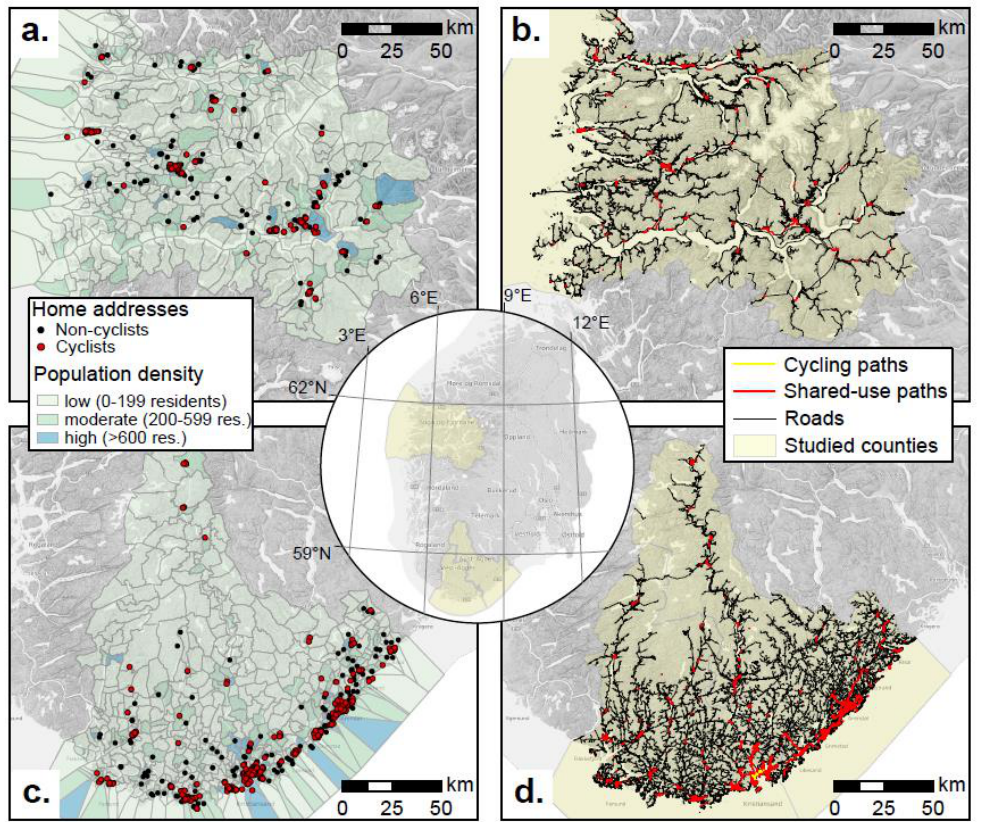
Figure 2. Geographic Information Systems (GIS)-derived information. ( a ) Population density and location of home addresses in Sogn og Fjordane; ( b ) Roads, cycling paths and shared-use paths in Sogn og Fjordane; ( c ) Population density and location of home addresses in Agder; ( d ) Roads, cycling paths and shared-use paths in Agder.